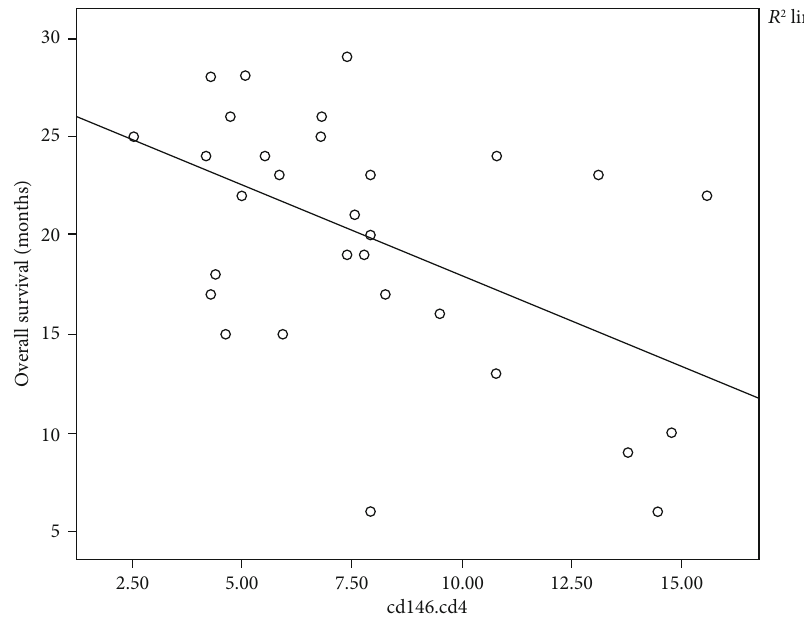
Figure 3: Scatter plot of the relation between CD146 + CD4 + cells and OS of 31 children with B-cell ALL.